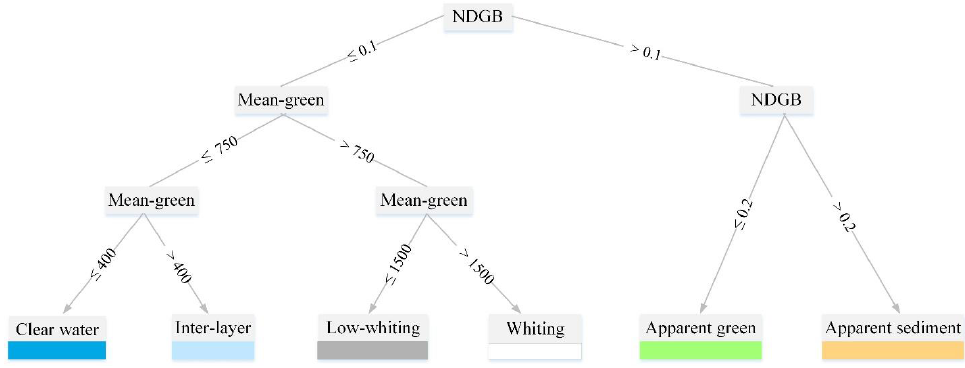
Figure 7. AdaBoost DT-generated model for developing rule sets for rule-based classification.